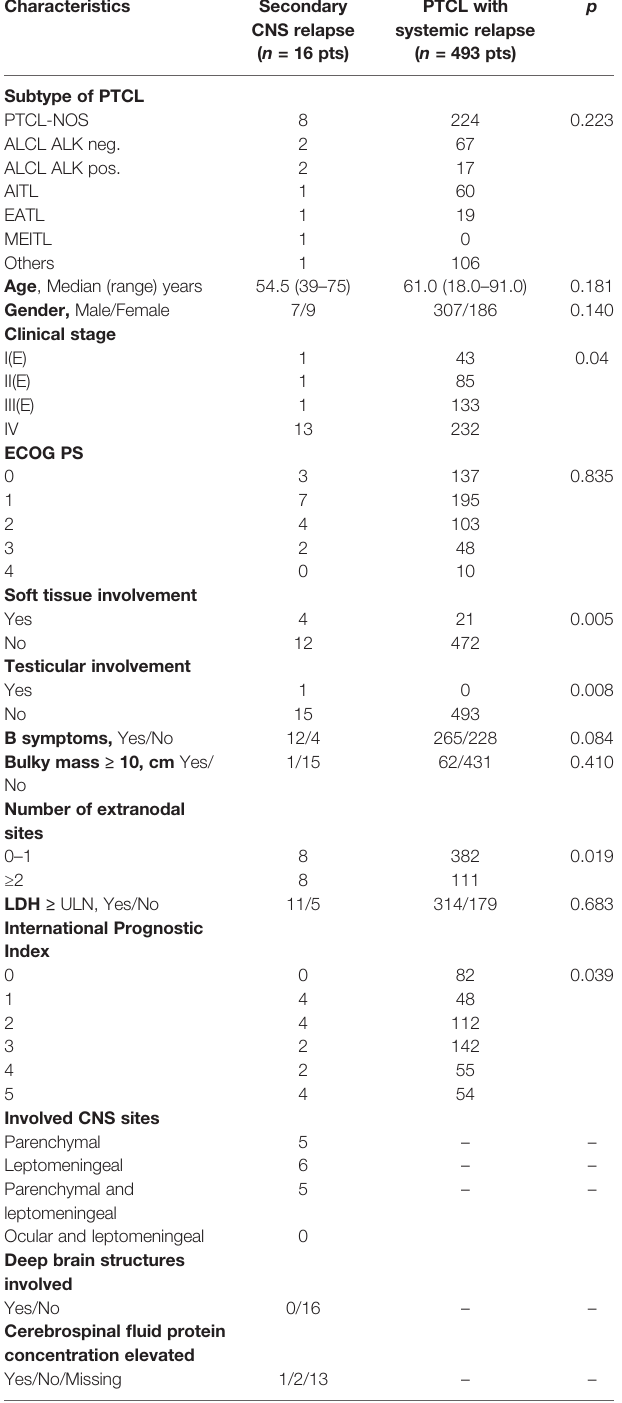
TABLE 2 | Characteristics of patients with secondary CNS relapse ( n = 16) and with systemic relapse of peripheral T-cell lymphomas ( n = 493). Characteristics